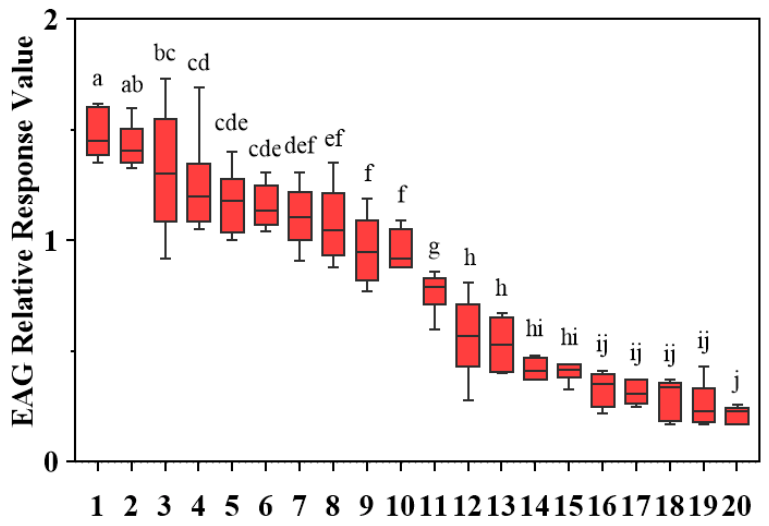
Figure 2. EAG relative response values of female Dendrothrips minowai to synthetic compounds. Means ( ± SEM) indicated by the same letter are not significantly different ( p > 0.05), and those indicated by different letters are significantly different ( p < 0.05). 1: P-anisaldehyde; 2: